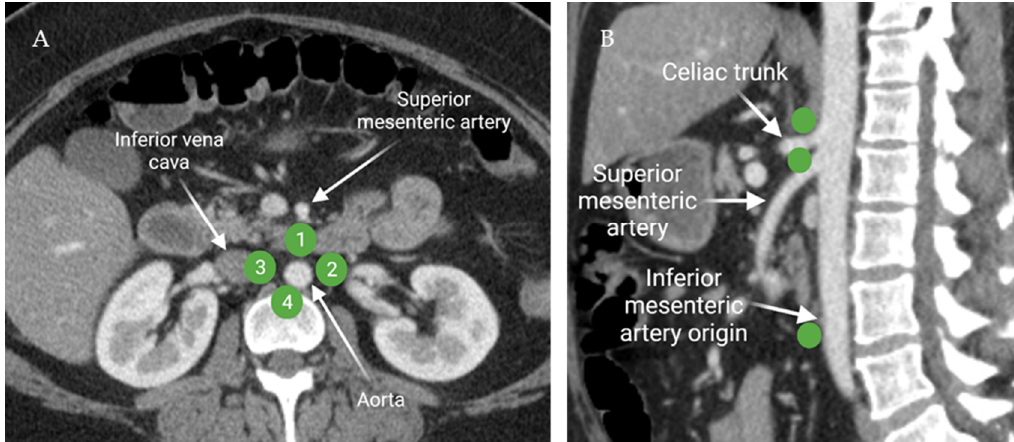
Figure 6. Axial contrast-enhanced CT of the abdomen ( A ) demonstrates the distribution of the peri-aortic lymph nodes: 1 ; pre-aortic, 2 ; left lateral aortic, 3 ; right lateral aortic, and 4 ; post-aortic. Sagittal contrast-enhanced CT of the abdomen ( B ) shows the distribution of the pre-aortic lymph nodes along the origins of the visceral branches of the aorta (celiac, superior mesenteric, and the inferior mesenteric arteries). “Created by BioRender.com. accessed on 10 August 2021”.